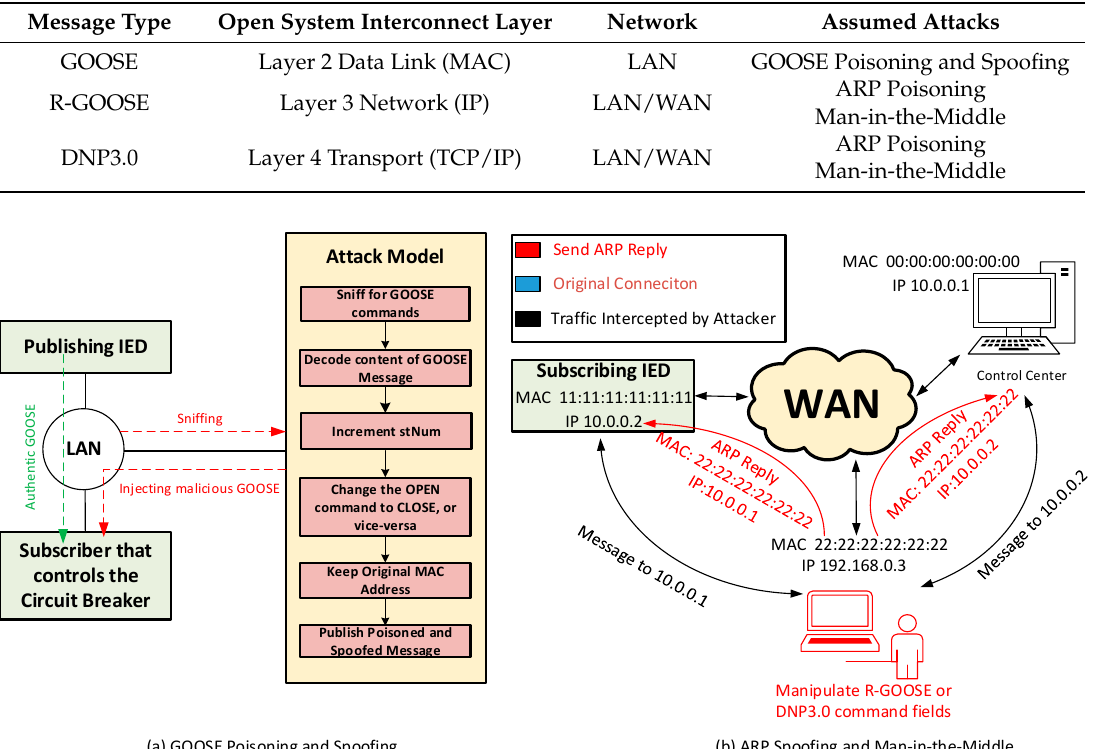
Figure 2. ( a ) Goose Poisoning and Spoofing Procedure; ( b ) ARP Poisoning and R-GOOSE and DNP3.0 Man-in-the-Middle Attack.